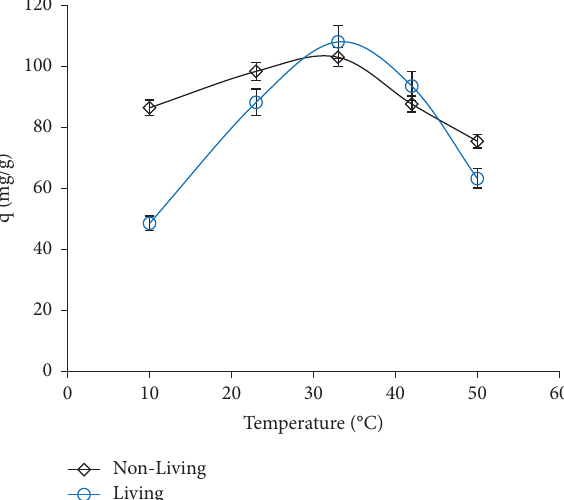
Figure 4: Efect of temperature on the uptake of Pb (II) by Pen- icillium notatum (pH: 5).